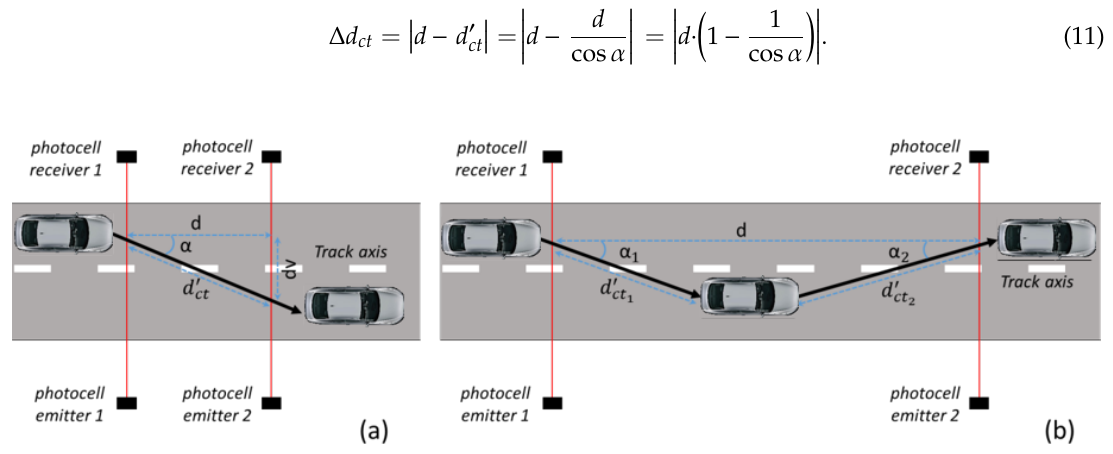
Figure 4. Uncertainty contribution due to the vehicle trajectory along the track: short distances ( a ) and long distances ( b ).